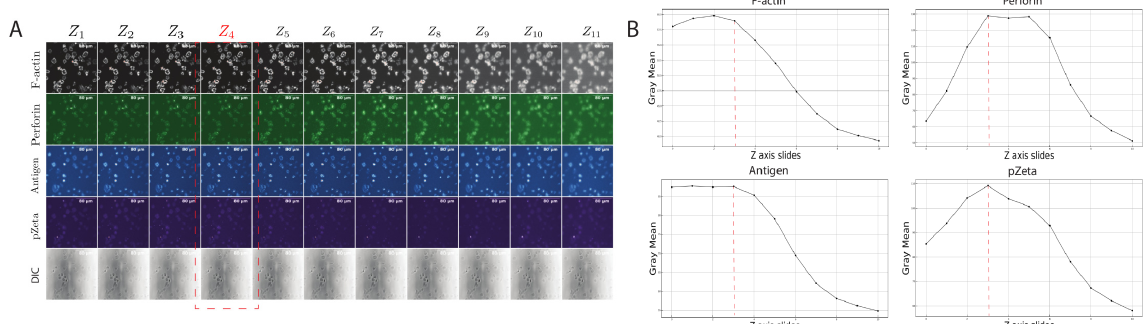
Fig 7. Successful image data extraction in a python environment. (A) Is a sample of 11 Z slides with five channels: F-actin at row 1 (channel 1), perforin at row 2 (channel 2), tumor antigen at row 3 (channel 3), pZeta at row 4 (channel 4) and, the DIC of the cells at row 5 (channel 5). To have clear representations of the cells in the figure, colormap filters are added to the original grayscale images: F-actin received ’RdGy_r’ colormap, perforin received ’PRGn_r’ colormap, tumor antigen received ’RdBu_r’ colormap, pZeta received ’PuOr_r’ colormap and, the DIC received ’binary’ colormap. The colormaps [61] are only used for representation purposes and do not affect the evaluation of the IS. (B) Plots the mean intensity values for grayscale images through Z slides for all